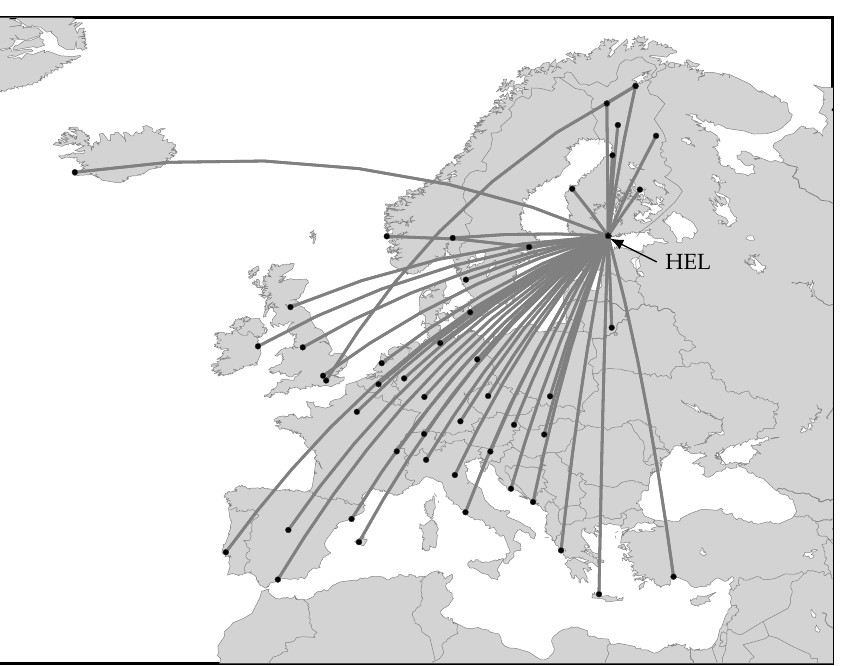
Figure 13. Route network of an Airbus A321-211 from Finnair (MSN 1185, Tailsign OH-LZC. Time period from 1 January 2019 to 31 December 2019 extracted from flightradar24.com (accessed on 1 September 2020)).